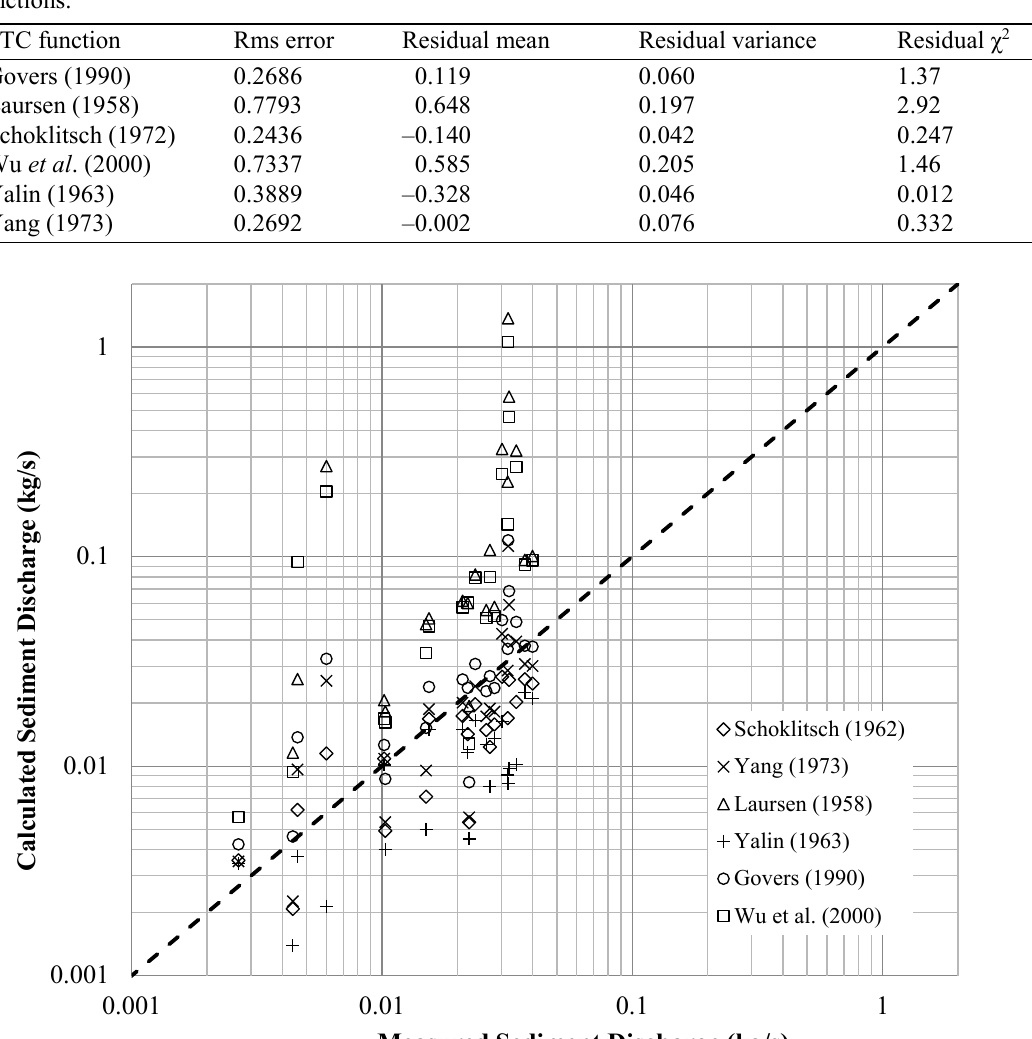
Fig. 2 Comparison of measured sediment discharge and that calculated by the evaluated STC